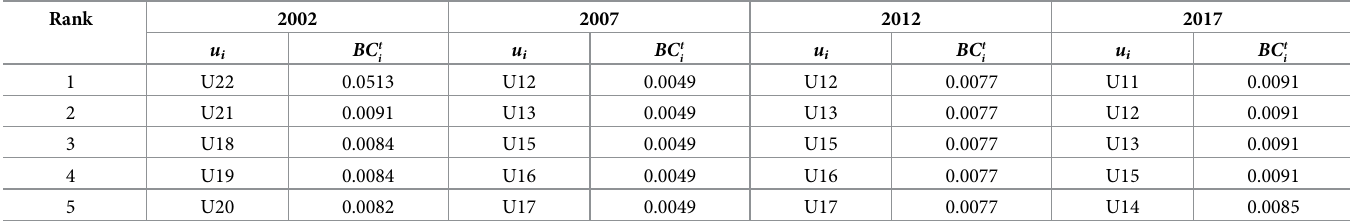
Table 3. Top 5 industries with betweenness centrality.